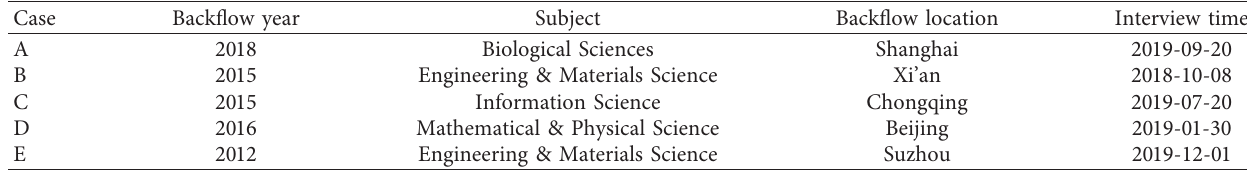
Table 2: Profile of five cases.